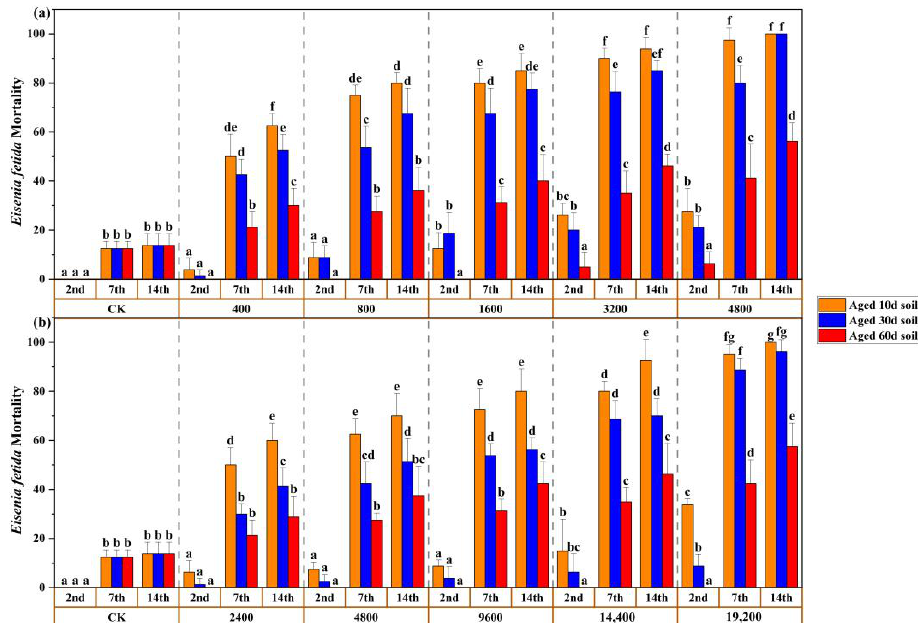
Figure 3. Mortality of E. fetida after 2 d, 7 d, and 14 d of exposure to Sb (III) ( a ) and Sb (V) ( b ) spiked soil aged for 10 d, 30 d, and 60 d. Error bars indicate standard deviations (n = 4). In the same dotted frame, bars with the different lowercase letter indicate significant differences between aging treatments at the same Sb (III) and Sb (V) concentration ( p < 0.05). The Sb (III) concentrations were prepared as CK, 400, 800, 1600, 3200, and 4800 mg/kg. The Sb (V) concentrations were prepared as CK, 2400, 4800, 9600, 14,400, and 19,200